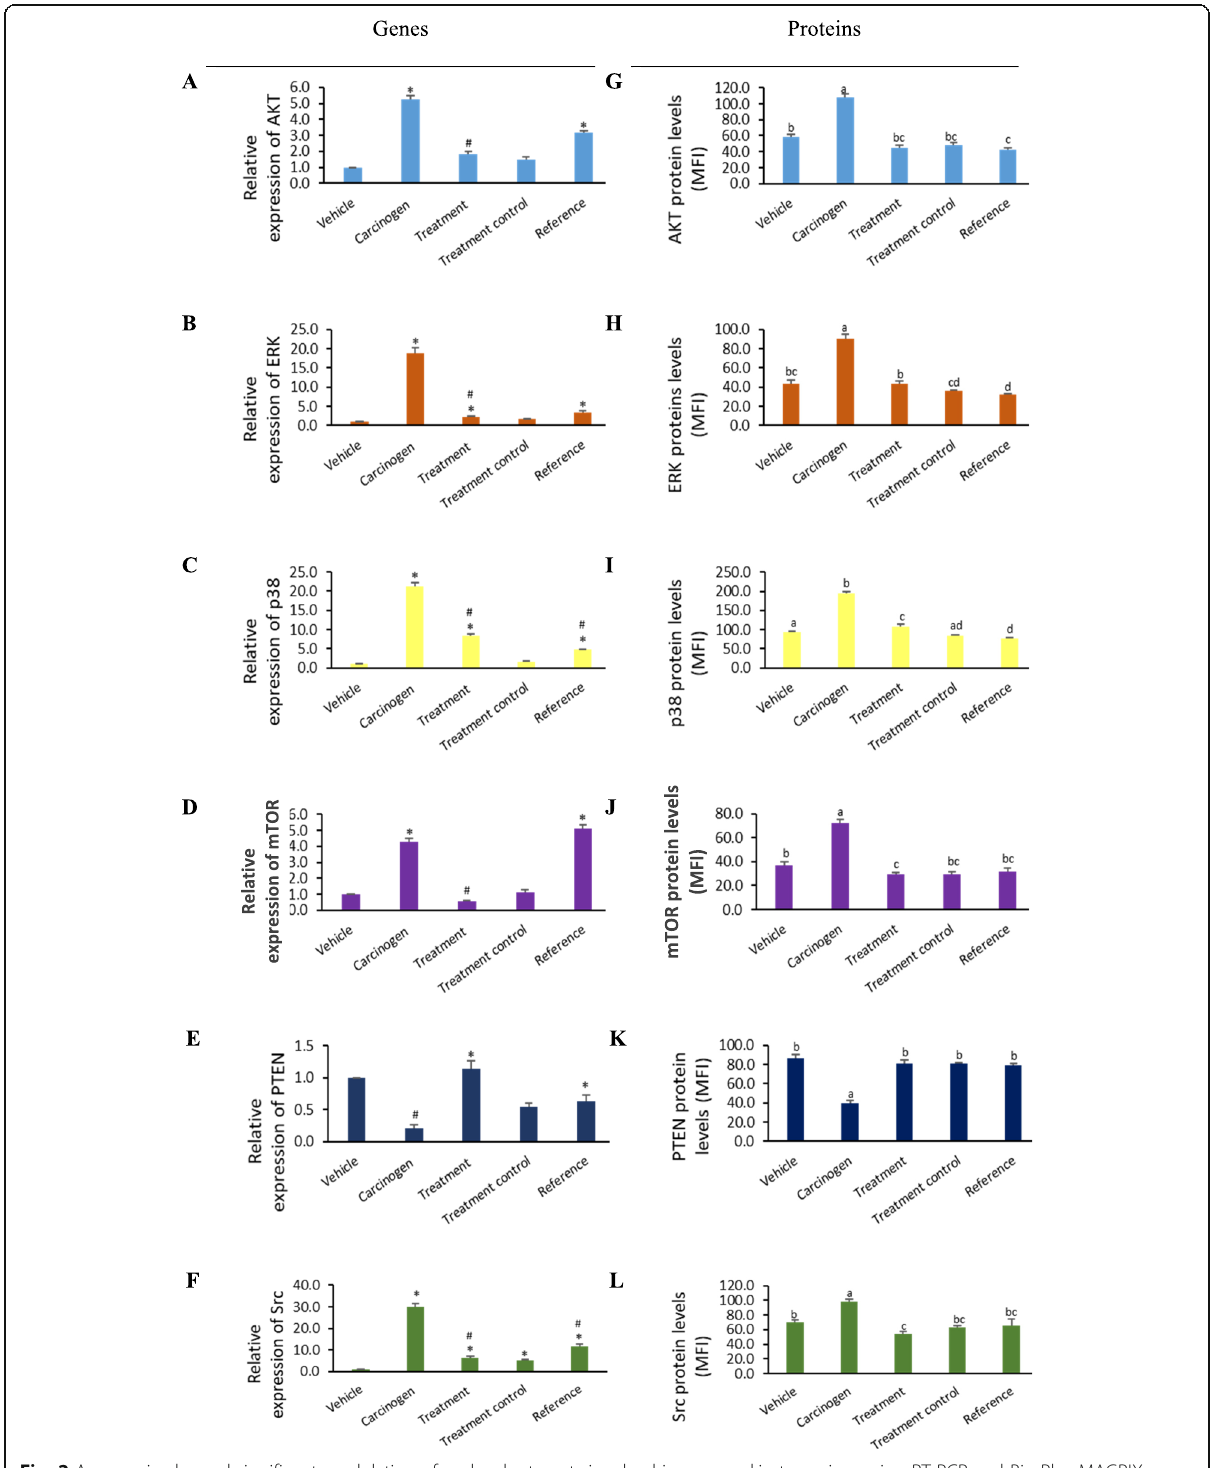
Fig. 2 Annonacin showed significant modulation of molecular targets involved in mouse skin tumorigenesis. qRT-PCR and Bio-Plex MAGPIX revealed down-regulation of AKT ( a , g ), ERK ( b , h ), p38 ( c , i ), MTOR ( d , j ), Src ( f , l ) and up-regulation of PTEN ( e , k ) genes and protein respectively in annonacin treated mouse skin tumorigenesis. * (significant up-regulation - values expressed as relative individual gene expressions to vehicle control group). # (significant down-regulation- values expresses as relative individual gene expression to carcinogen control group). Values with different superscripts letter among the groups are statistically significant ( p < 0.05). All experiments were performed in